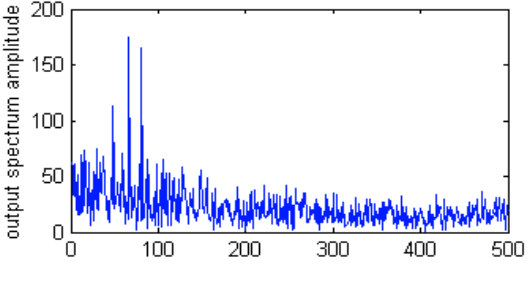
Figure 6. Frequency spectrum of output. The parameter is: b =1; θ =0.9; a